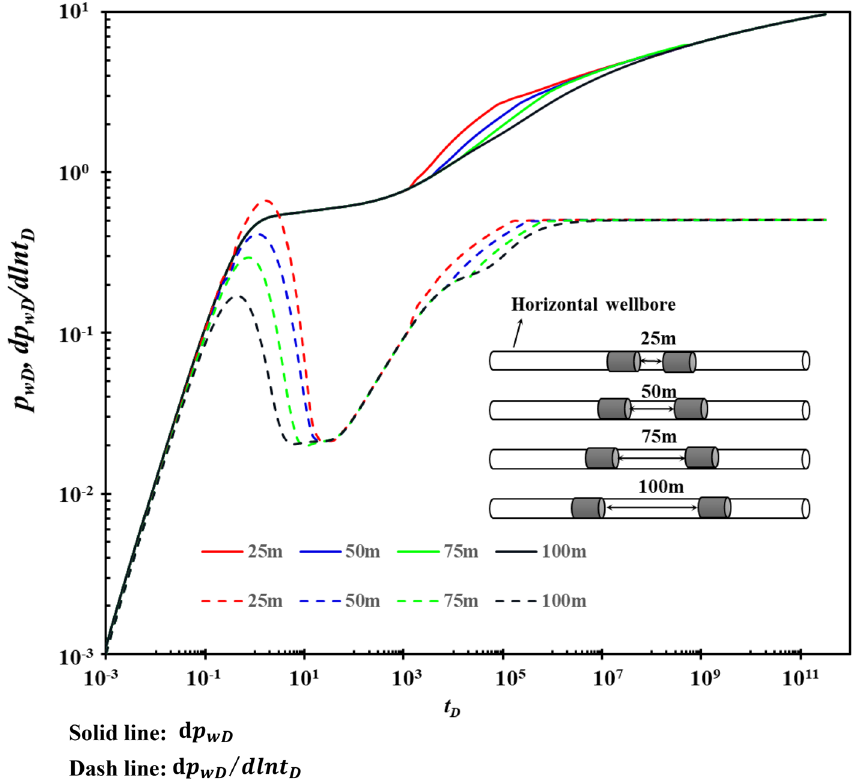
Figure 9. The effect of segment spacing on type